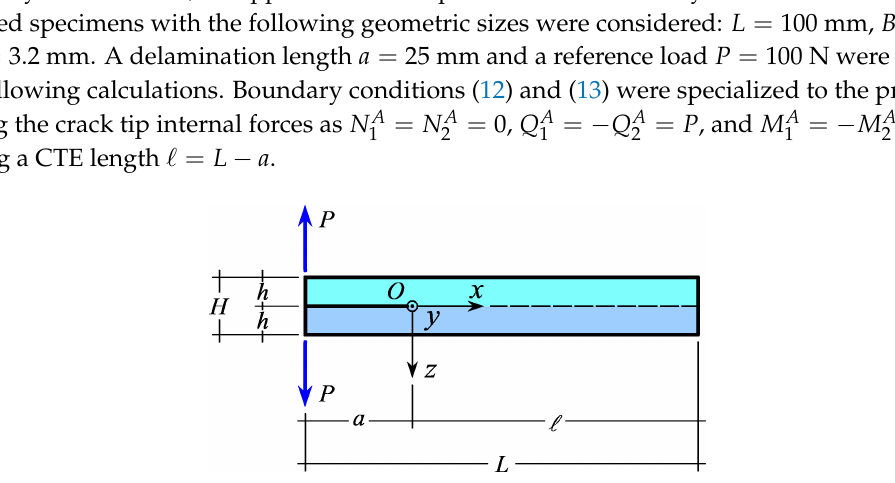
Figure 3. Double cantilever beam test.